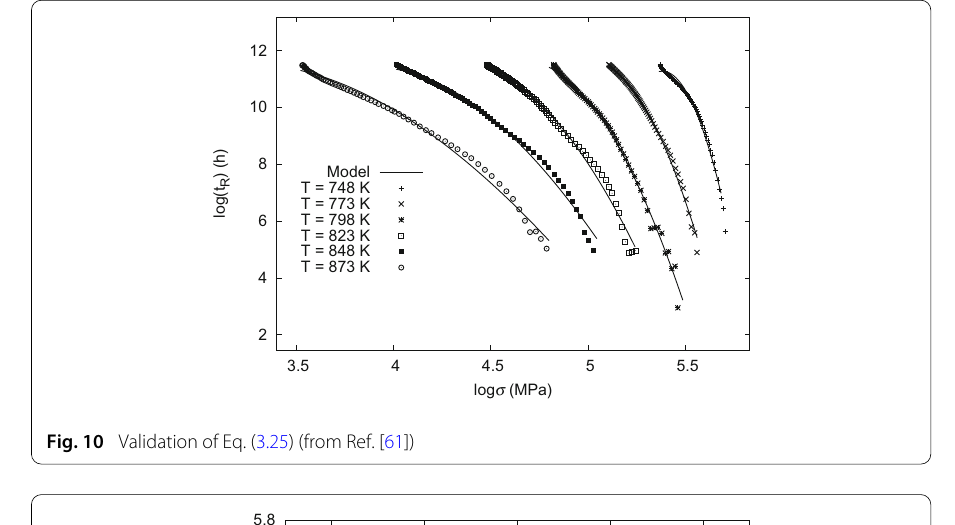
Fig. 10 Validation of Eq. (3.25) (from Ref. [61])